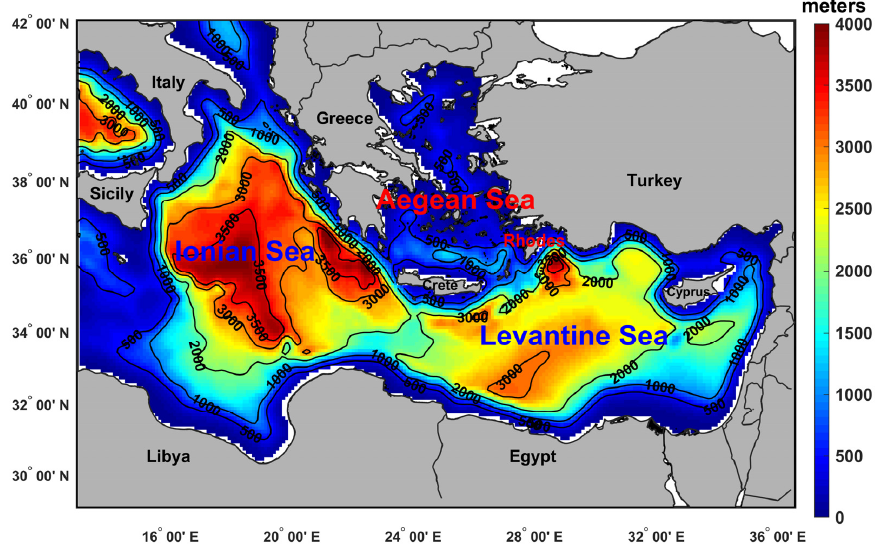
Figure 1. The bathymetric map of the EMED with the main geographic features and sub-basins. Bathymetry and topography are from General Bathymetric Chart of the Oceans GEBCO dataset (www.gebco.net) (accessed on 20 December 2022).